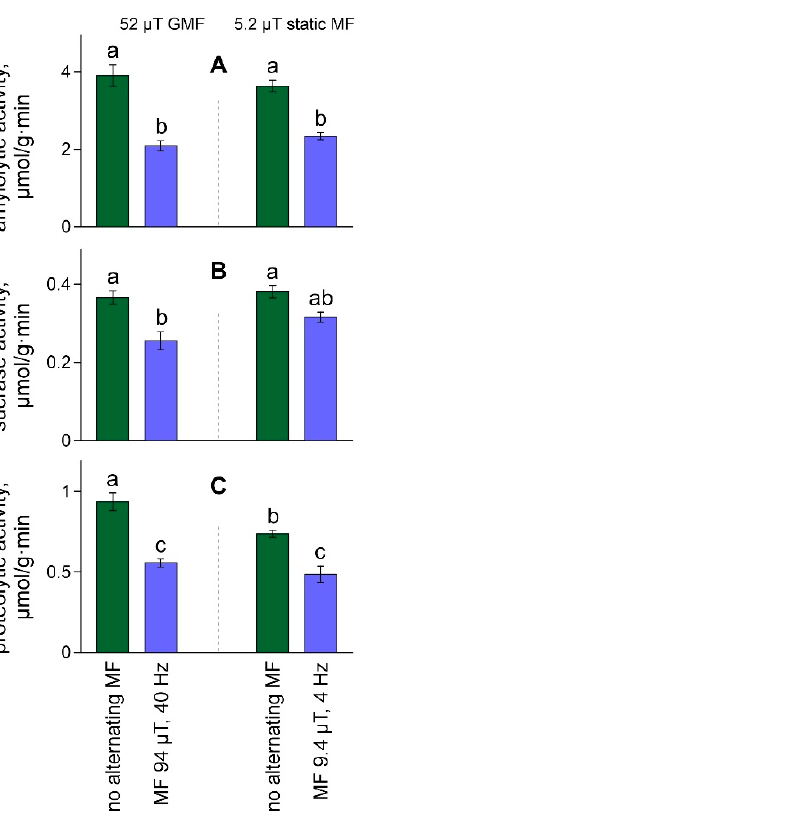
Figure 3. The amylolytic activity ( A ), sucrase activity ( B ), and proteolytic activity ( C ) in the whole- body homogenates of daphnids exposed to studied magnetic fields. Values are means ± standard error. Significant differences ( p < 0.05) among groups after Tukey’s post-hoc multiple comparison tests indicated by different letters.